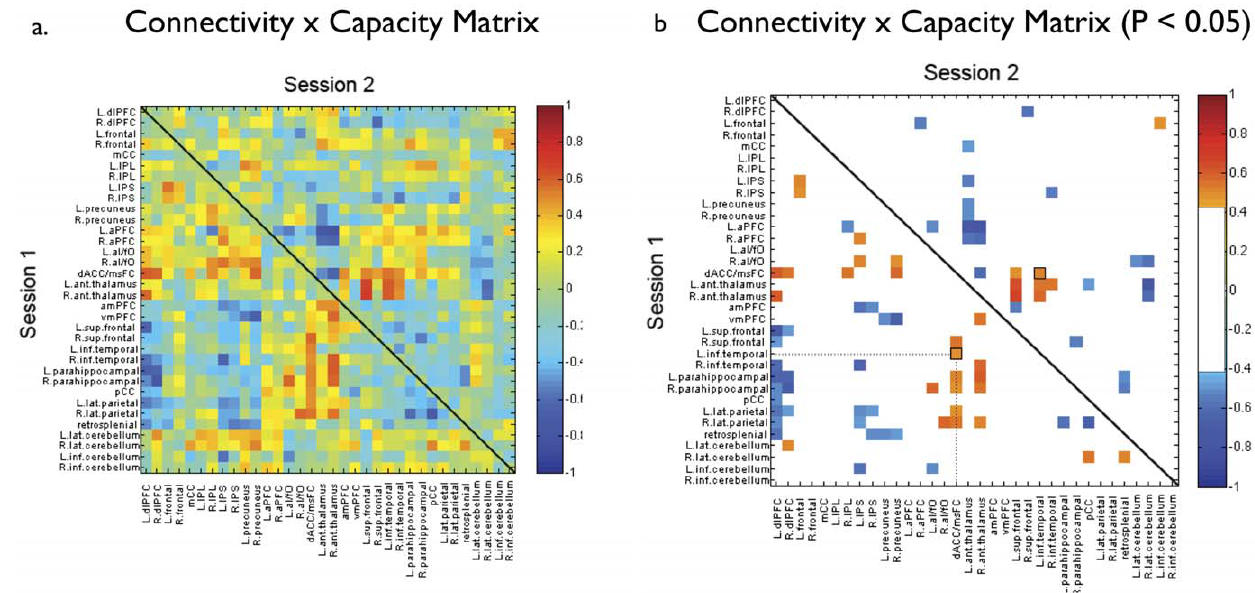
Figure 4. The correlation matrix for connection weights between nodes and VSTM. Capacity a ) in Session 1 (lower triangle) and Session 2 (upper triangle). b ) For clarity, the same correlation matrix with non-significant connections eliminated (threshold r=0.47, p # 0.05, uncorrected for multiple correlations).